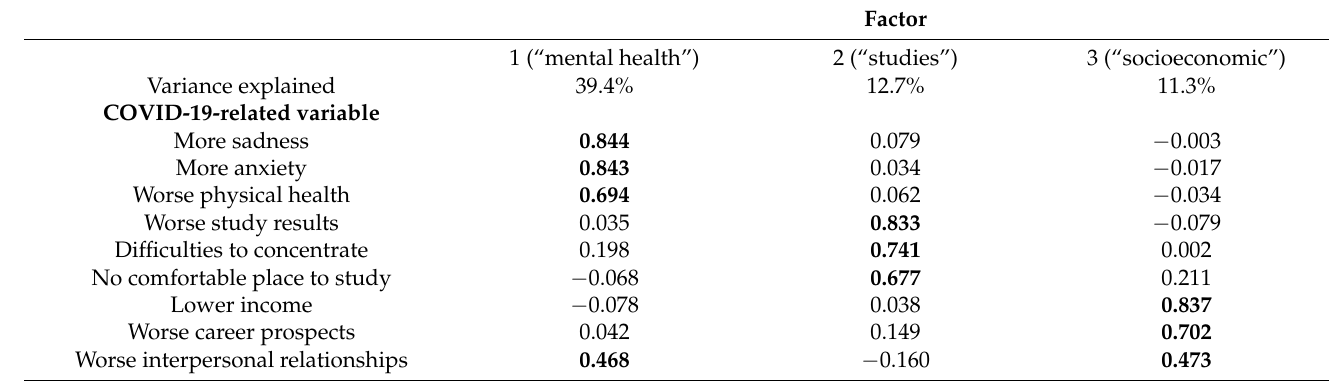
Table 2. Results of an exploratory factor analysis (principal component analysis) after an oblique rotation (factor loadings > 0.40 are in bold) when questions related to the consequences of the COVID-19 pandemic were